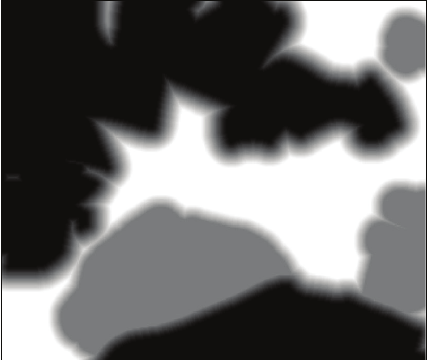
Figure6:Visualizationofcalculationresultsofcoefficient 𝐶 3